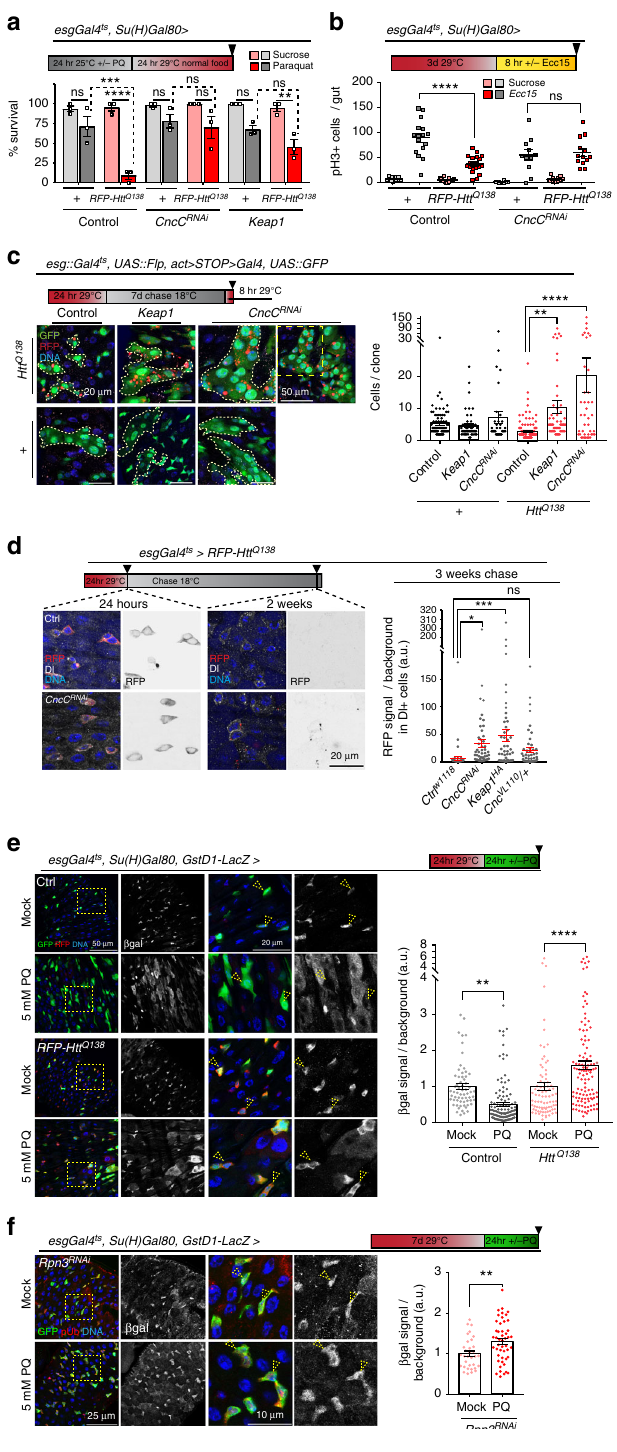
linked transgenes is achieved by co-expression of Gal4 with a temperature-sensitive version of the Gal4 inhibitor Gal80 45,46 . Expression of mRFP-Htt Q138 was induced for 24 h, and was